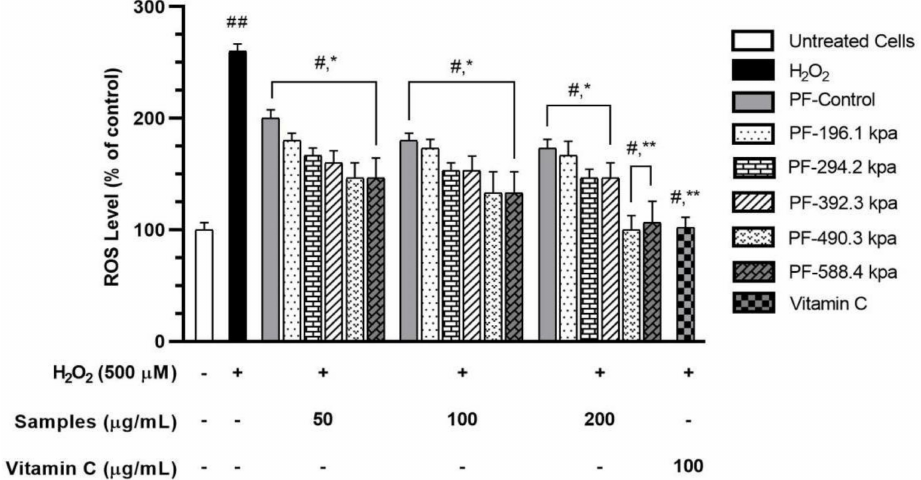
Figure 8. Intracellular ROS level (% of control) in HaCaT cells induced oxidative stress with H 2 O 2 . Cells were exposed to 500 µ mol/L of H 2 O 2 for 2 h and treated with various concentrations of samples (50, 100 and 200 µ g/mL) for 24 h. The graph represents the mean ± SD values of four replications. # p < 0.05 ## p < 0.01 indicates significant differences from control group, * p < 0.05 ** p < 0.01 indicates significant differences from the H 2 O 2 stimulation